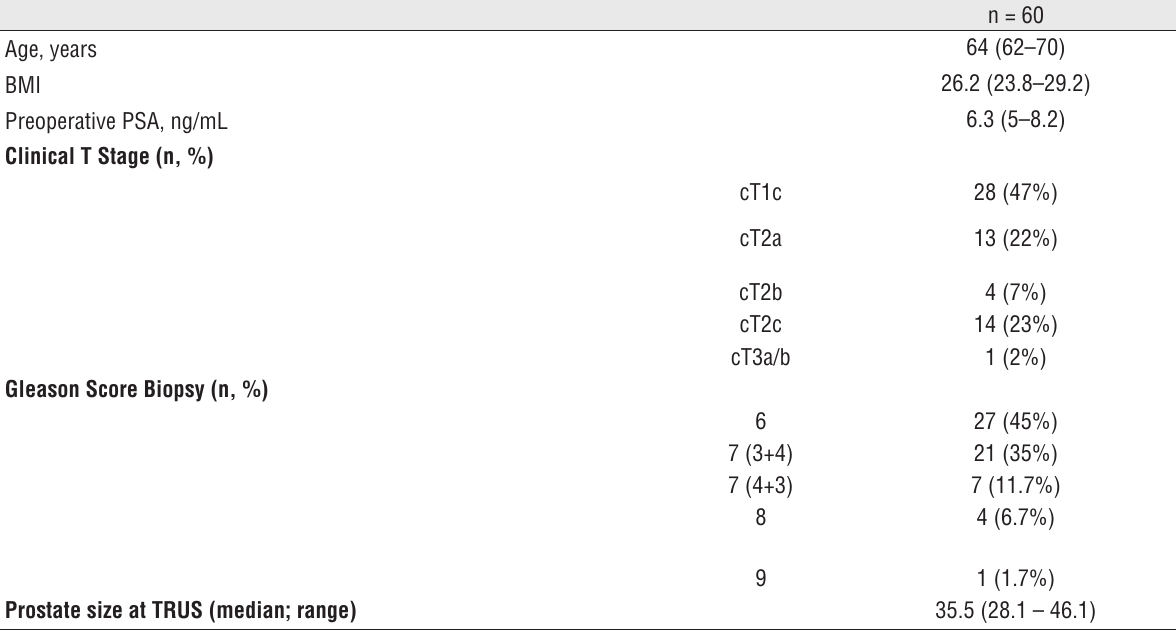
Table 1 - patients’ demographics.